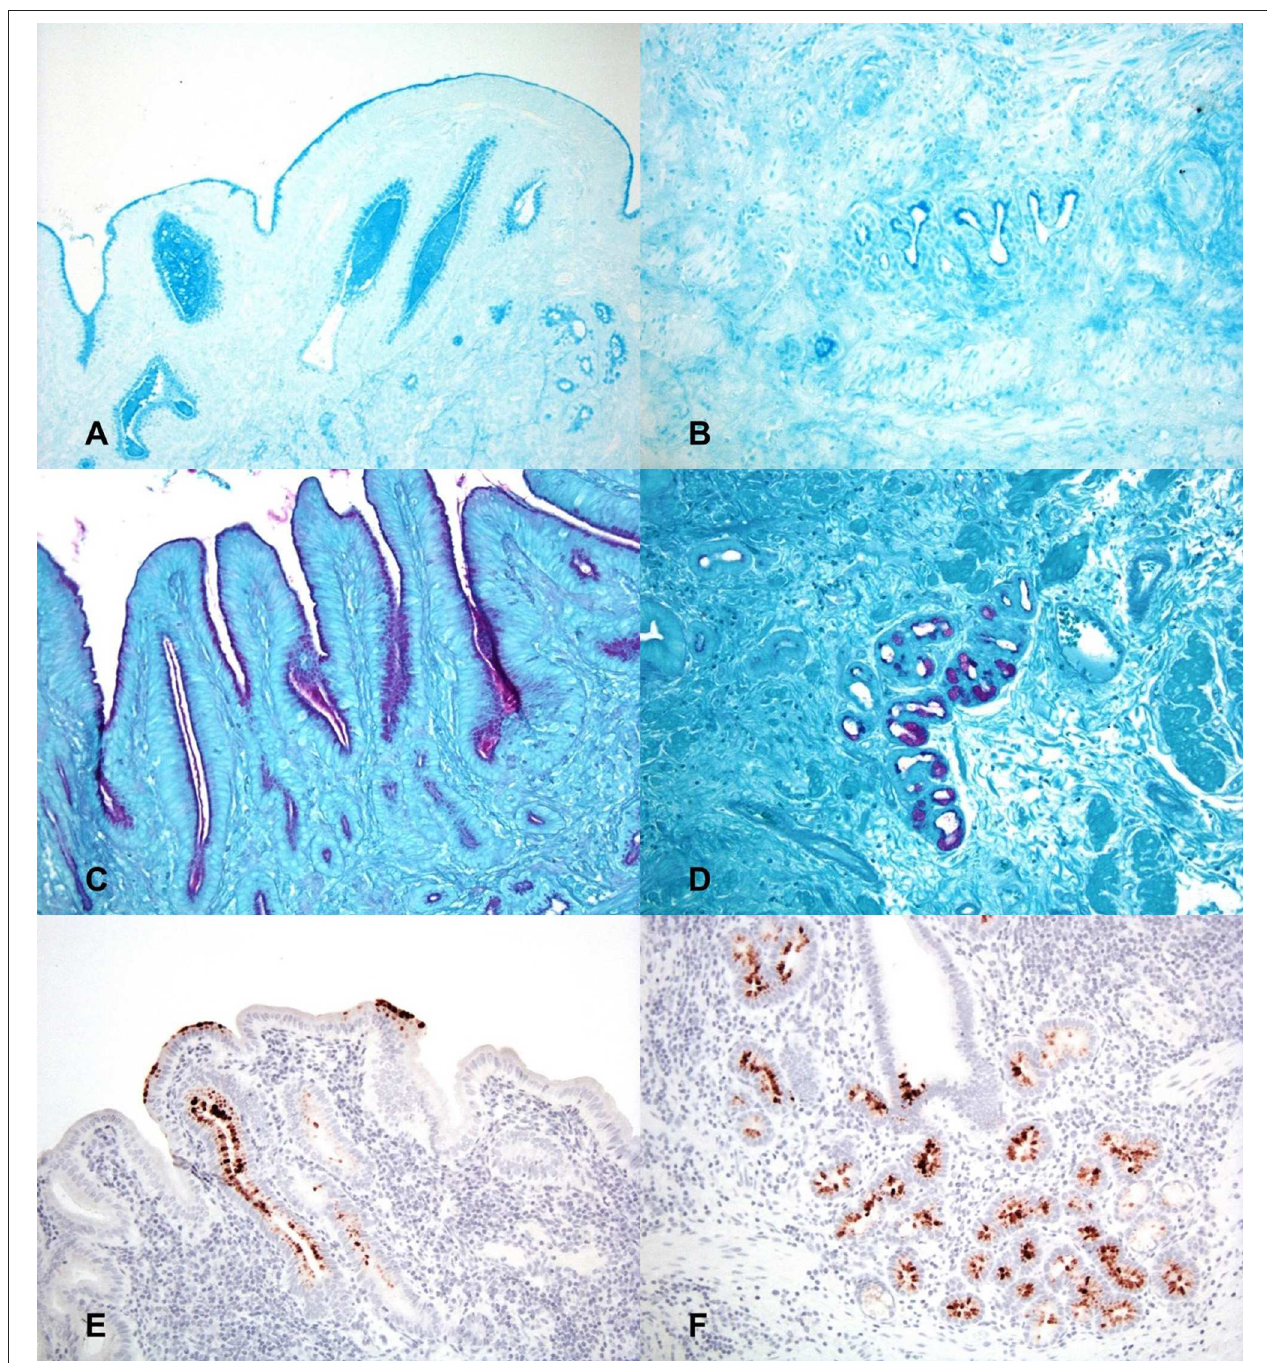
FIGURE 3 | Histochemical staining for putative growth factors in gallbladders inoculated with C. jejuni . (A) The mucosal surface and deep invaginations are lined with moderate amounts of acid mucin (deep blue staining) and there are pools of acid mucin within the lumen of invaginations at 2h post-inoculation. Alcian blue (pH 2.5). (B) At 24h post-inoculation acid mucin staining is largely absent in the necrotic surface mucosa but is still marked within the cells and the lumen of deep mucosal invaginations. Alcian blue (pH 2.5). (C) The apical cytoplasm of mucosal epithelial cells and the lumen of mucosal invaginations contain large amounts of neutral mucin (purple staining) 2h post-inoculation. PAS staining. (D) Neutral mucin staining is also marked within submucosal glands. PAS staining. (E) 2h post-inoculation the mucosal surface and mucosal invaginations are lined with large amounts of L-fucose (brown staining). Lectin staining for L-fucose. (F) The deep mucosal invaginations and submucosal glands also contain large amounts of L-fucose 2h post-inoculation. Lectin staining for L-fucose.